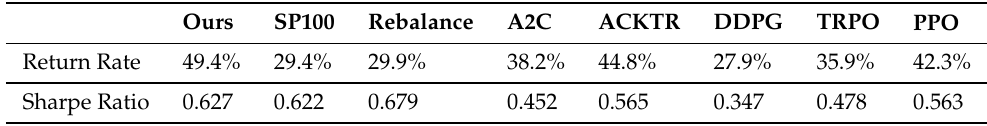
Table 2. The results of total returns and Sharpe